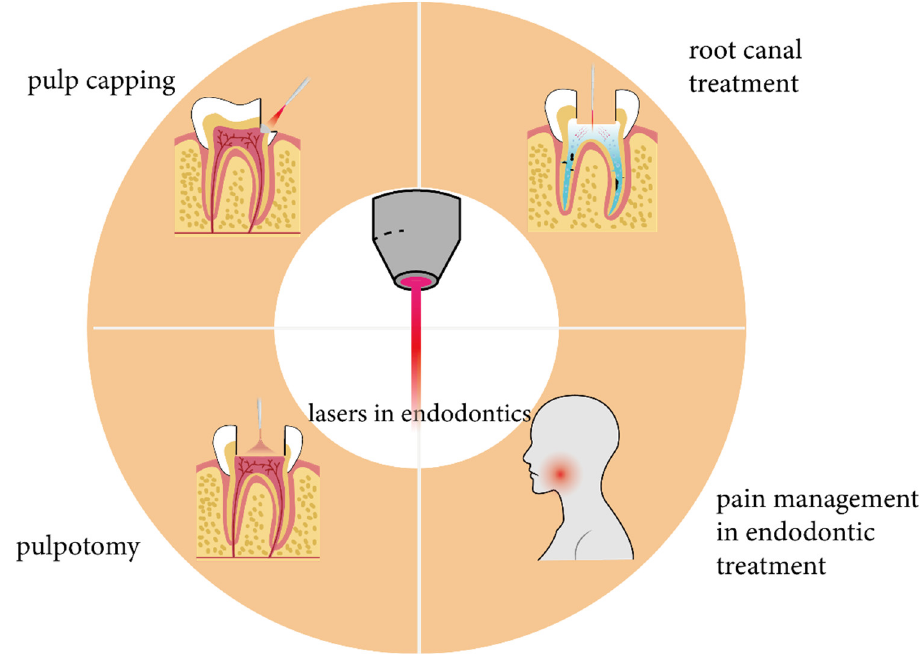
Figure 1. Applications of lasers in endodontics.